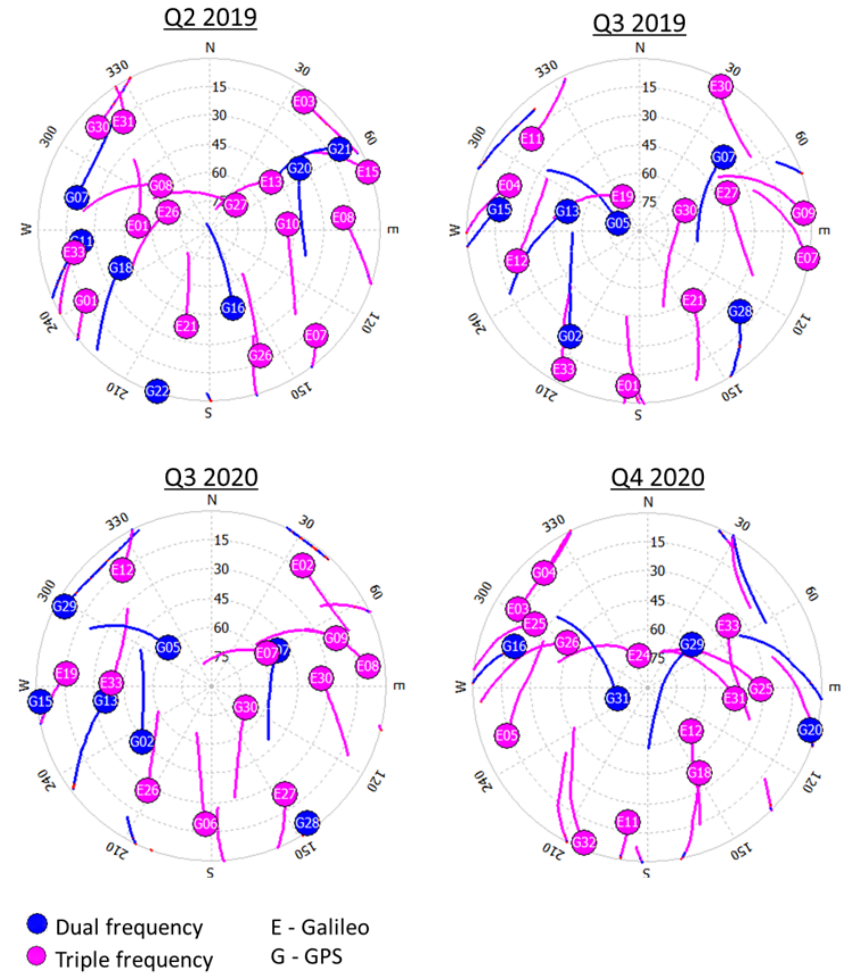
Figure 10. Skyplots for Galileo and GPS during the four aerial campaigns.